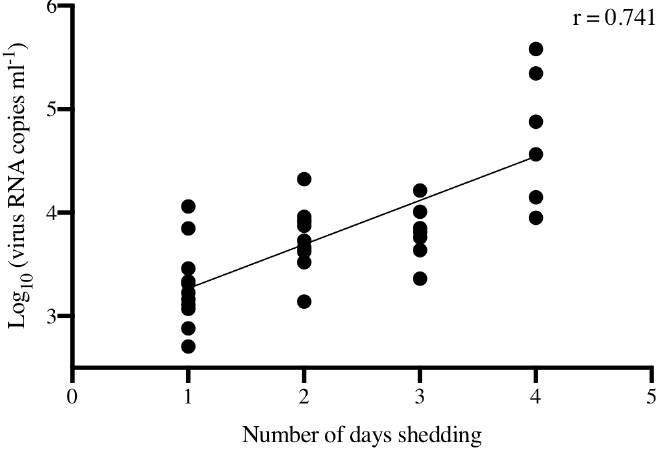
Figure 7. Correlation between the total quantity of virus shed by individual fish and the total num- ber of days shedding detectable virus, irrespective of virus strain or fish population. Pearson r cor- relation coefficient is reported ( p < 0.0001). coefficient is reported ( p <